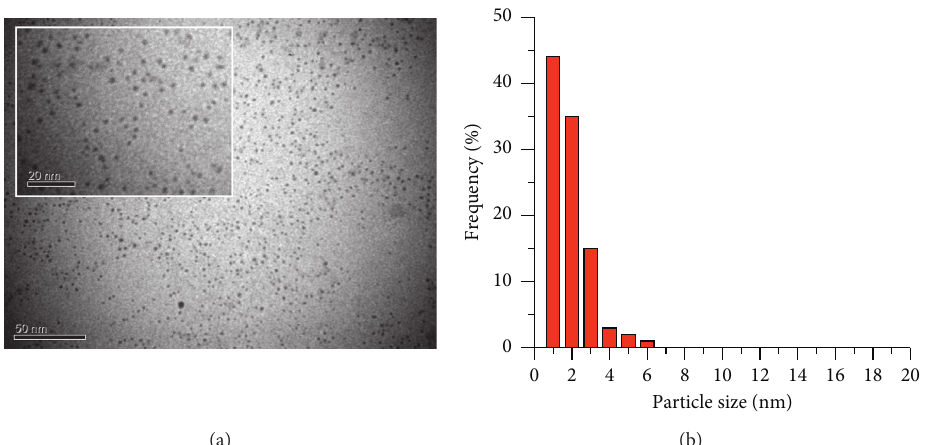
Figure 1: TEM images (a) and the size distribution histograms (b) of AgNPs, synthesized in RL solution (2g/L) at 40 cycles, t � 20 ° C.